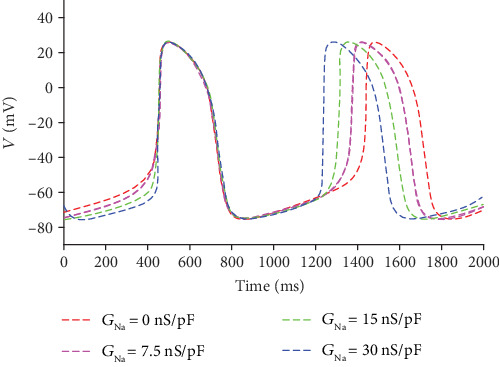
APs corresponding to different GNa.